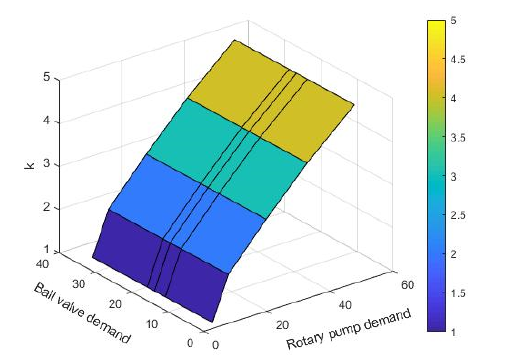
Fig. 5: The number of time intervals as the demand